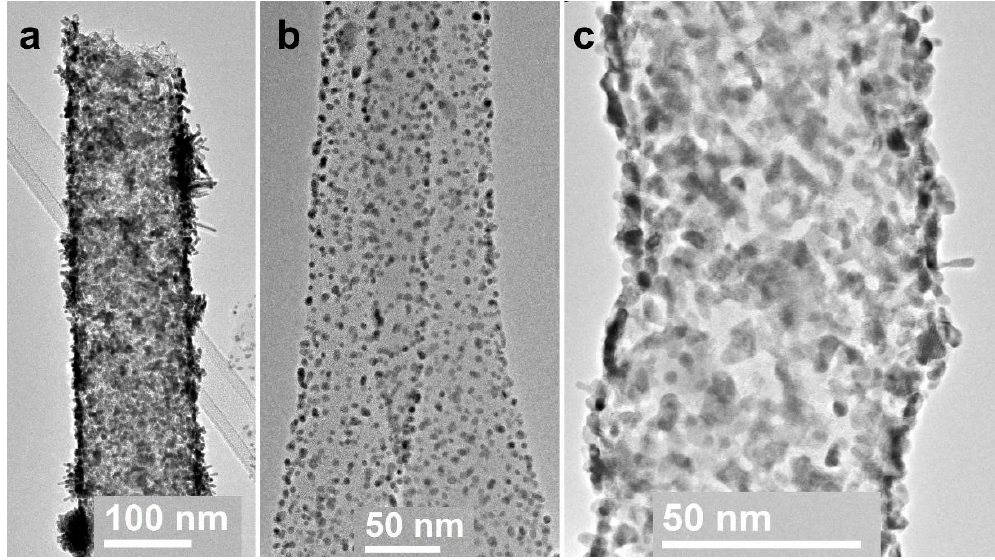
Figure 3. TEM images of Pt morphology for platinated pyrolyzed composite 1: ( a ) needle-like; ( b ) spherical; ( c ) intermediate (random).